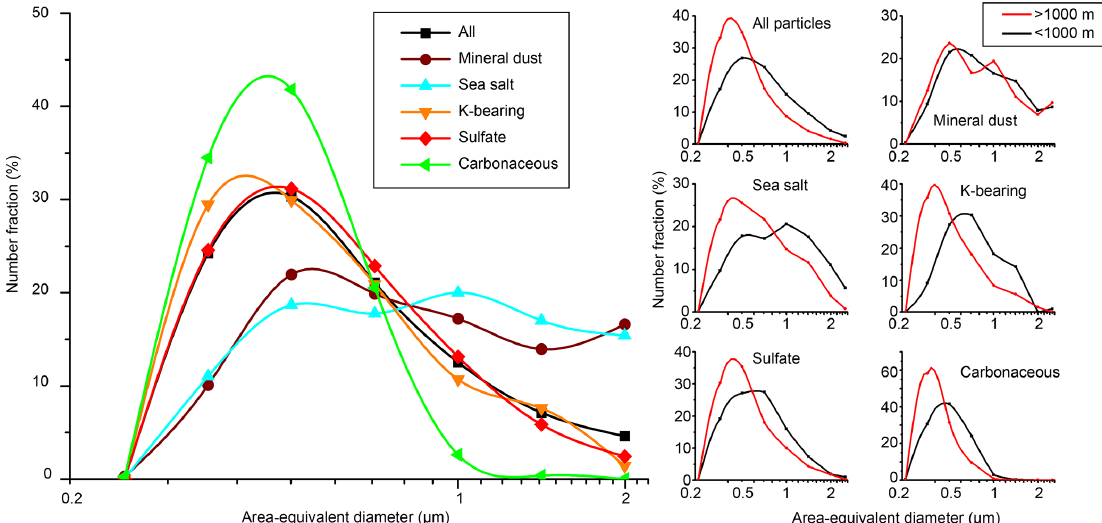
Figure 2. Normalized size distributions of each particle type for all samples (left) and for samples at altitudes above and below 1000m (right). The particle sizes were determined from the area-equivalent diameters obtained from the STEM images. The size bins are shown on a log scale and are < 0.25, 0.25–0.35, 0.35–0.5, 0.5–0.71, 0.71–1.00, 1.00–1.41, and > 1.41µm. The number fraction values indicate the percentage of particles in each bin size among each particle type. The particle numbers used for the mineral-dust, sea-salt, K-bearing, sulfate, and carbonaceous particles are 7844, 337, 1205, 421, 4672, and 809, respectively.